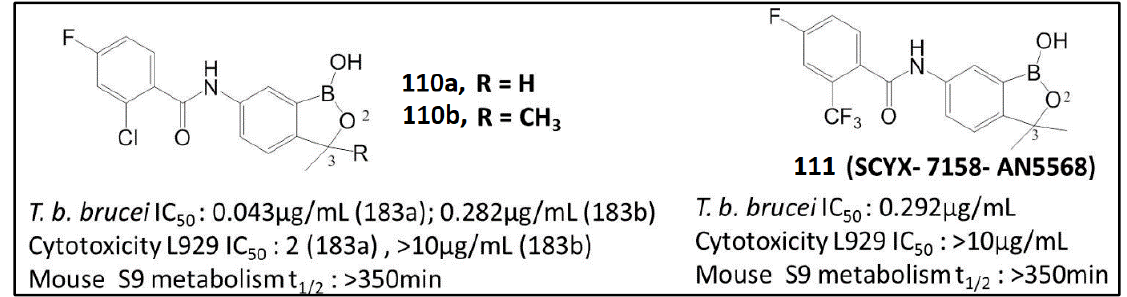
Figure 11. Structures, antitrypanosomal activity, cytotoxicity and biological half-life t 1/2 of benzoxaboroles 110 and 111 (Adapted from [98]).